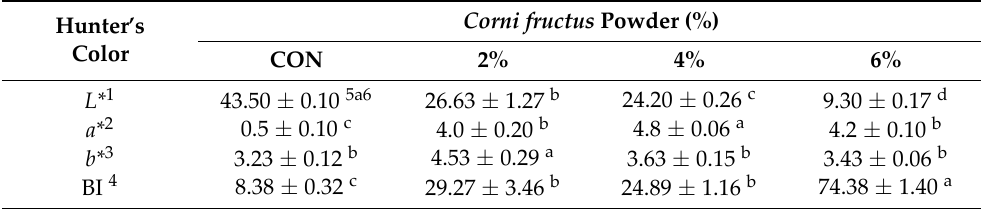
Table 3. Hunter’s color properties of Yanggaeng treated with Corni fructus powder.